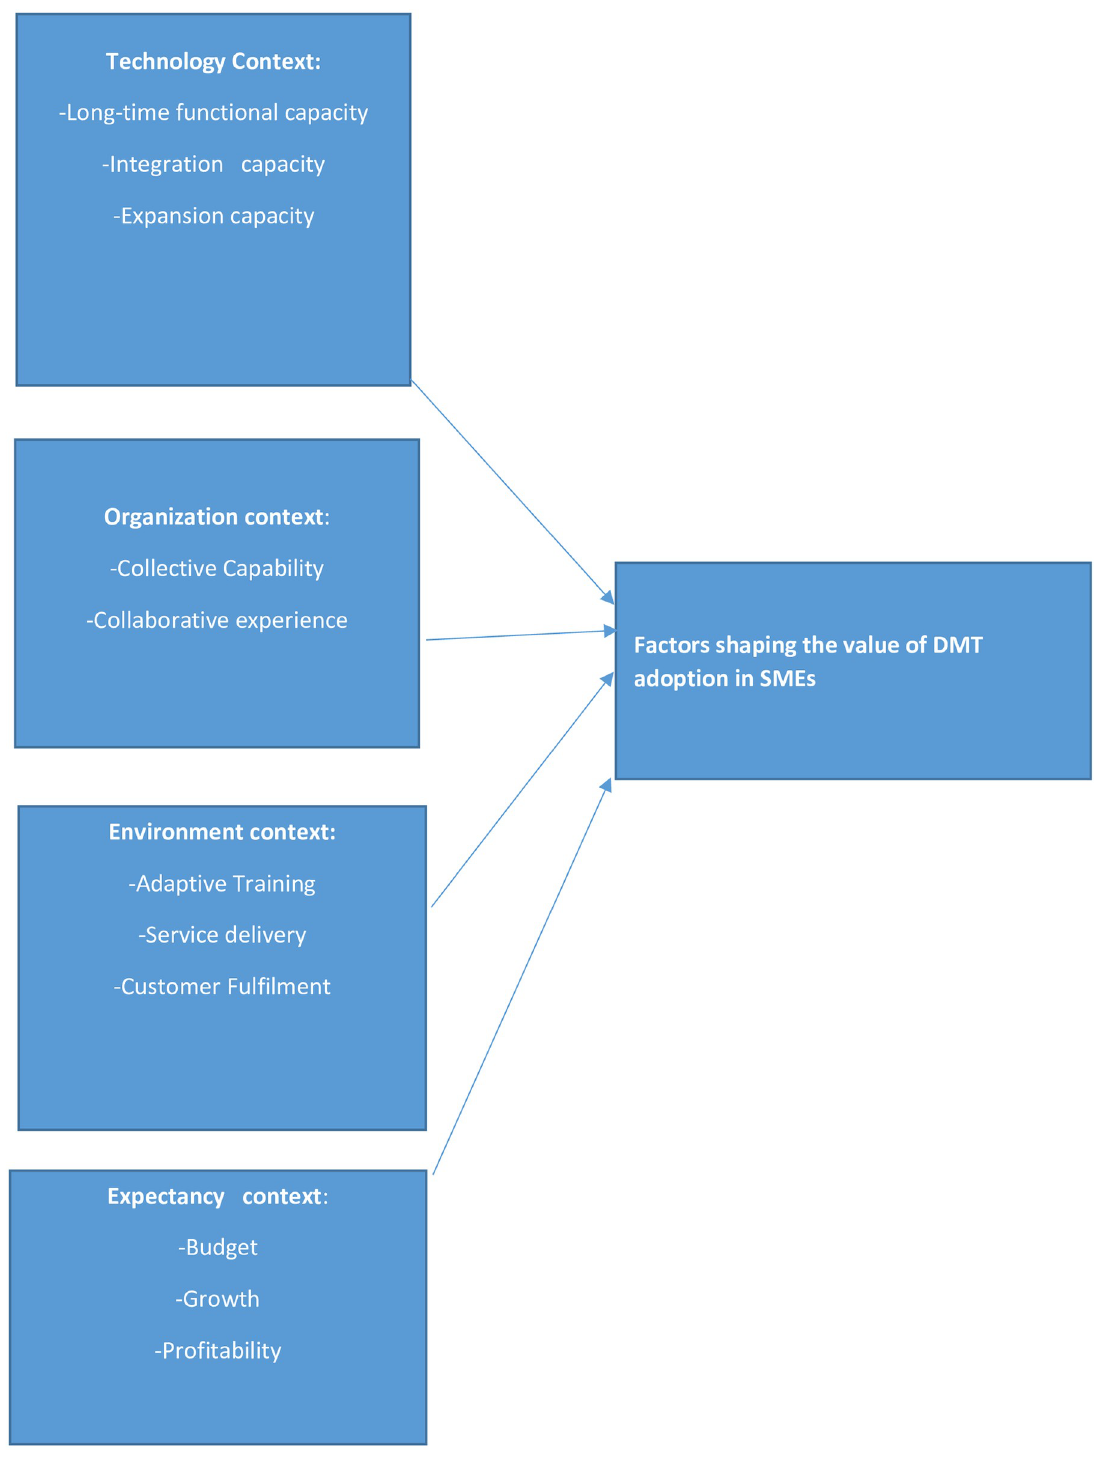
Fig 2. Factors stimulating values micro-businesses attach to digital marketing devices is about here.